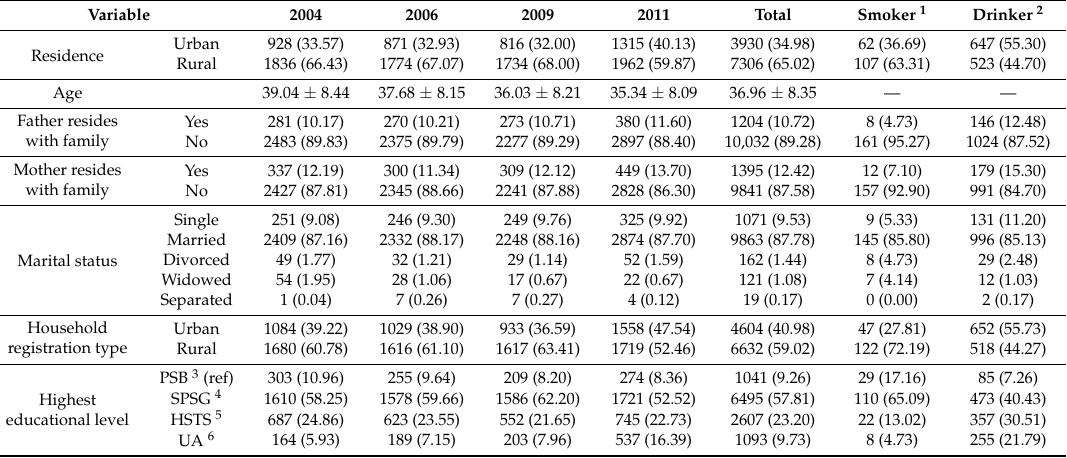
Table 1. Characteristics of 11,236 participants stratified by survey year ( N ,